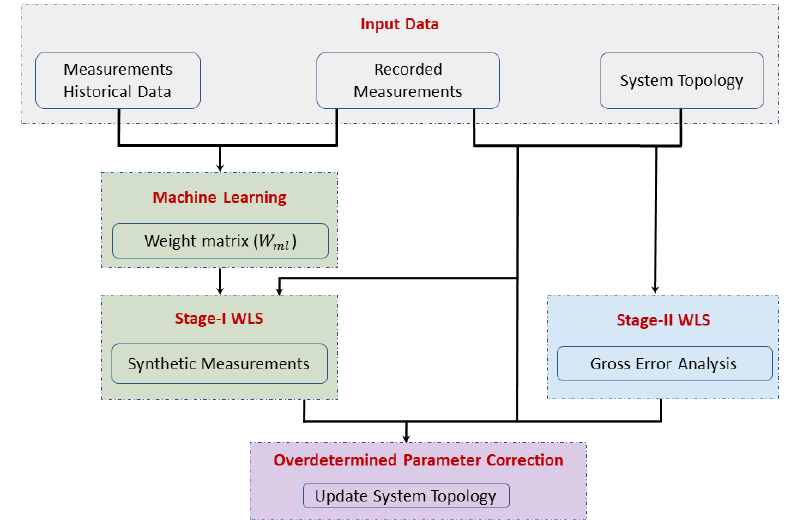
Figure 2. Framework for parameter FDI